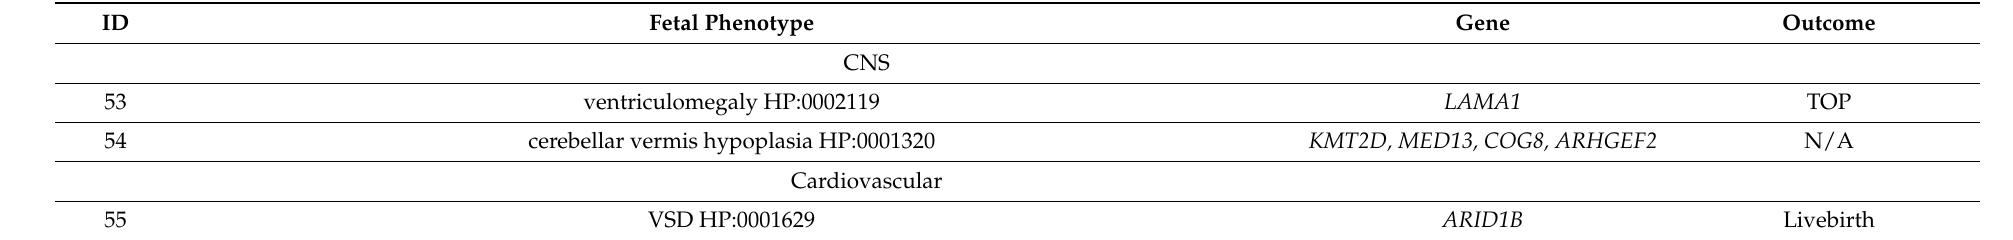
Table 3. Sonographic findings in fetuses with VUSs detected in exome sequencing—detailed